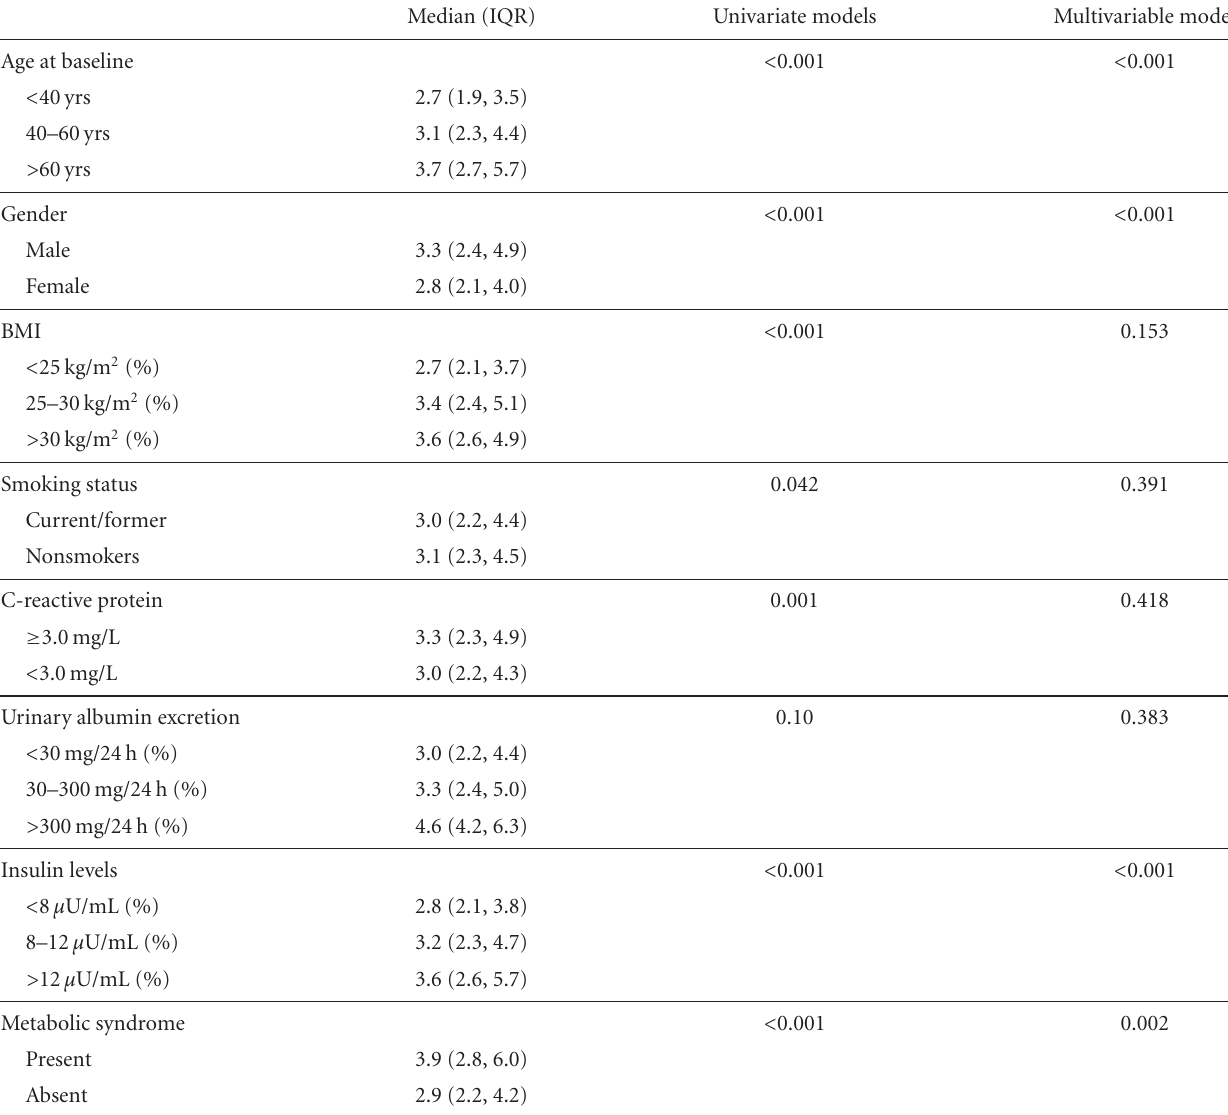
Table 3: t-PA antigen levels (ng/mL) for the association of the metabolic syndrome and other covariates.